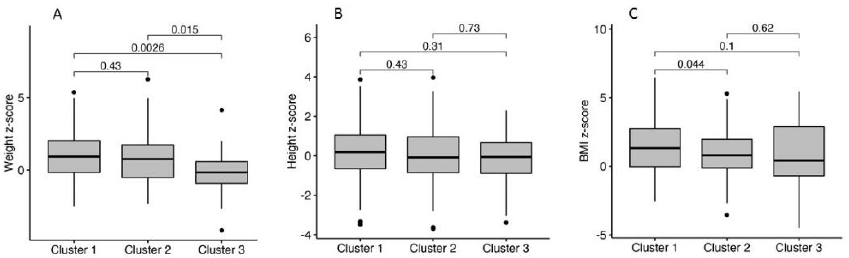
Figure 3. Comparison of normalized anthropometric parameters (( A ) weight z-score, ( B ) height z-score, and ( C ) BMI z-score) among the three clusters.